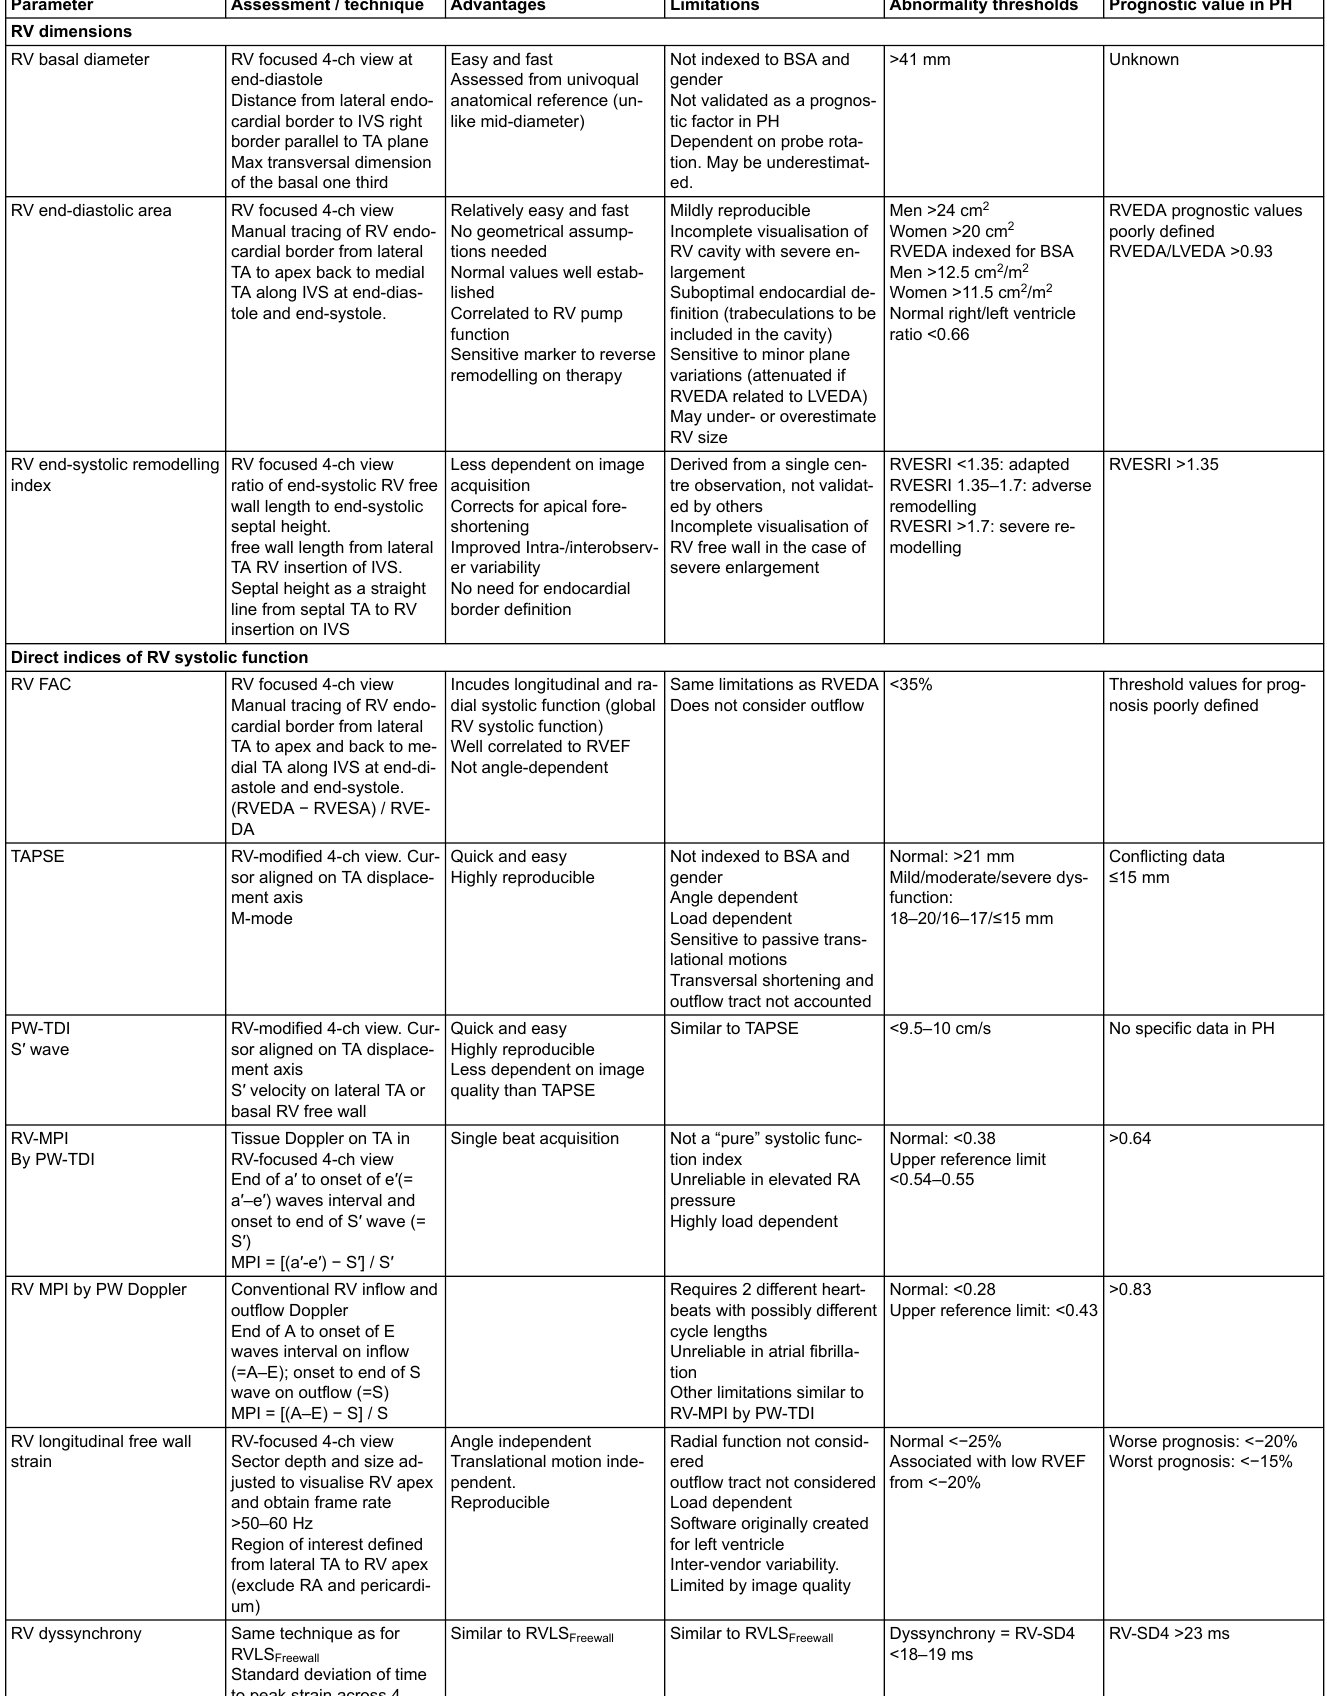
Table 2: Echocardiographic assessment of right ventricular size and systolic function (see text for references).